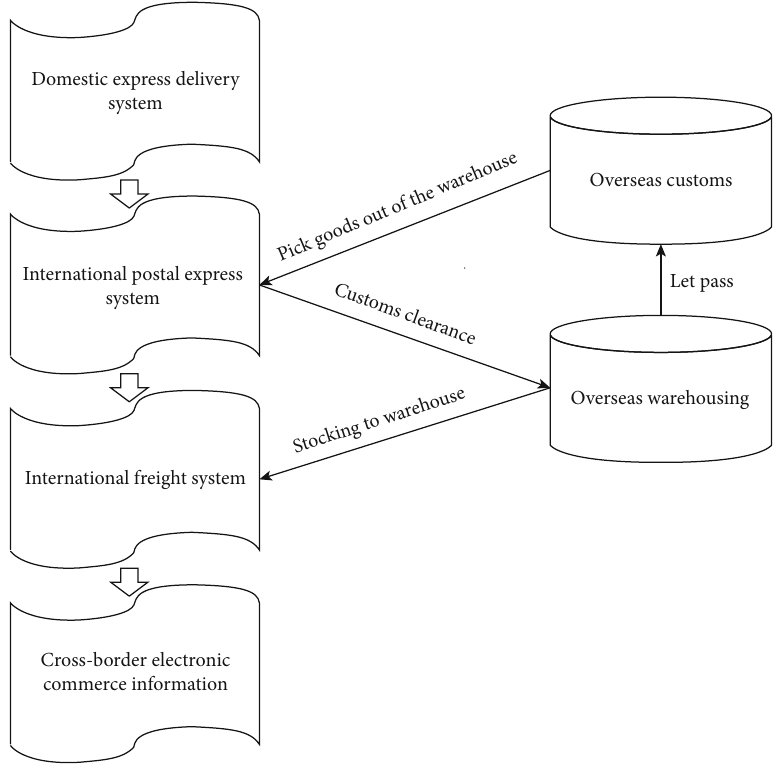
Figure 3: E-commerce across boarders logistics supply chain node structure